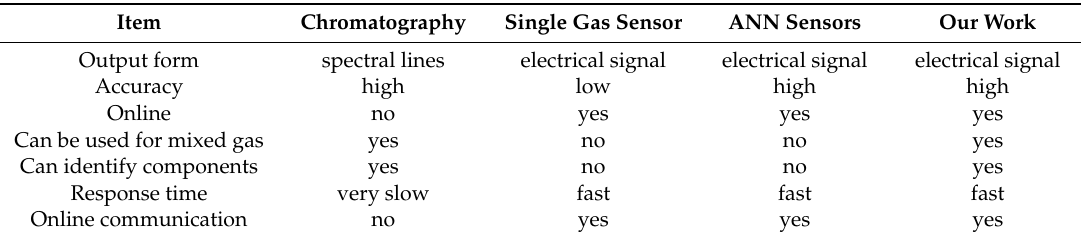
Table 4. Comparison of our work with other related